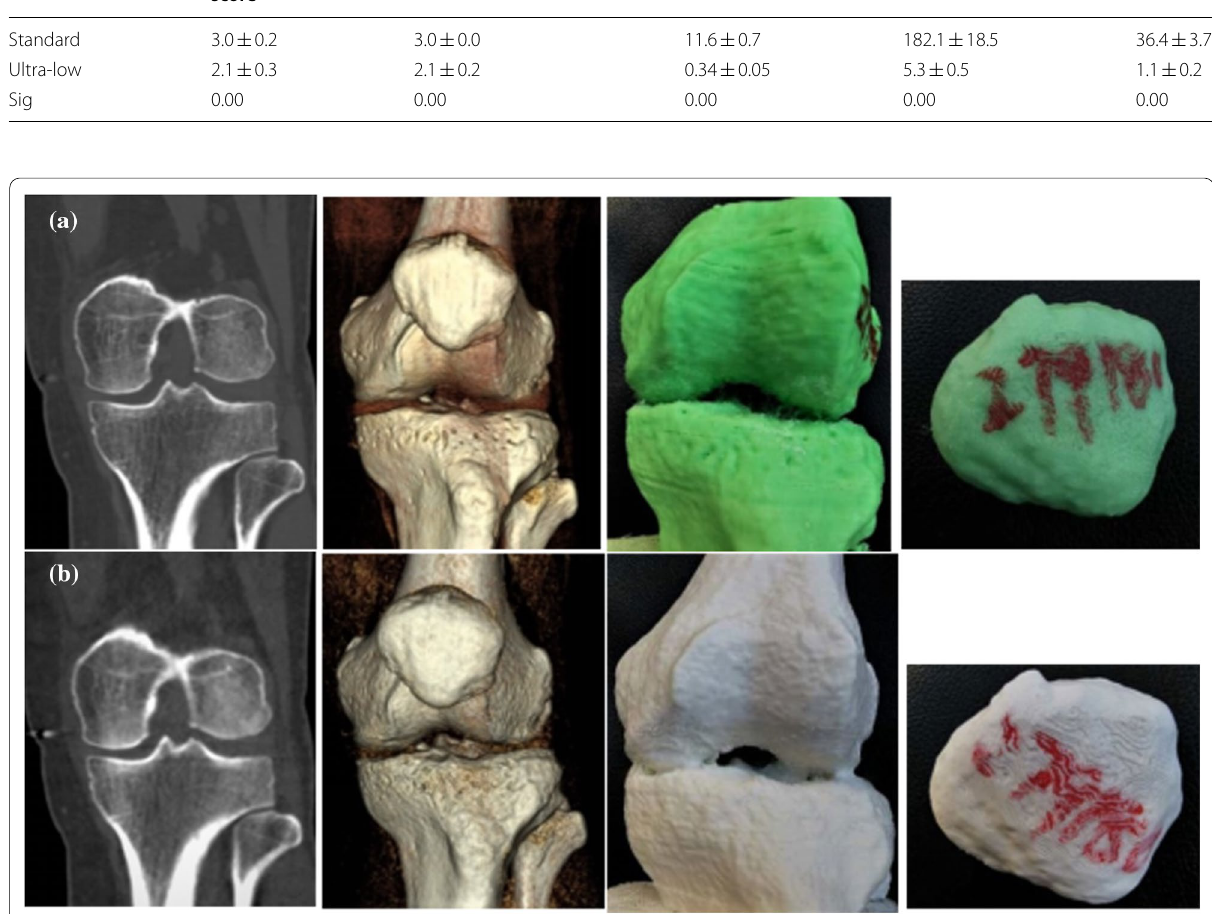
Table 2 Subjective evaluation of 3D printed model and Image quality and parameters of each group Dose group